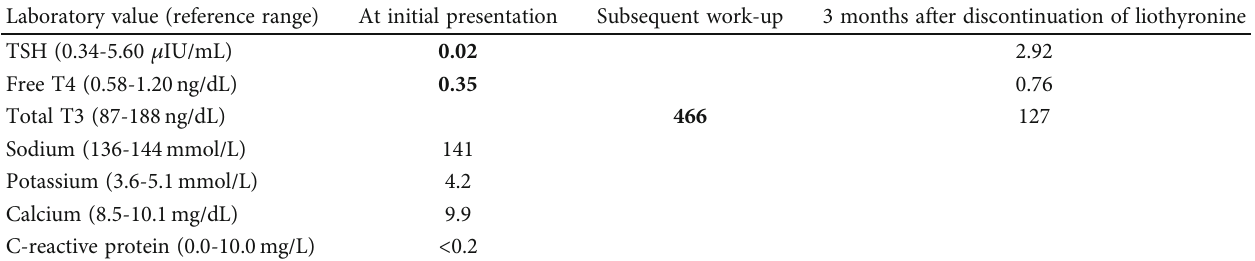
Table 1: Laboratory values before and after discontinuing liothyronine